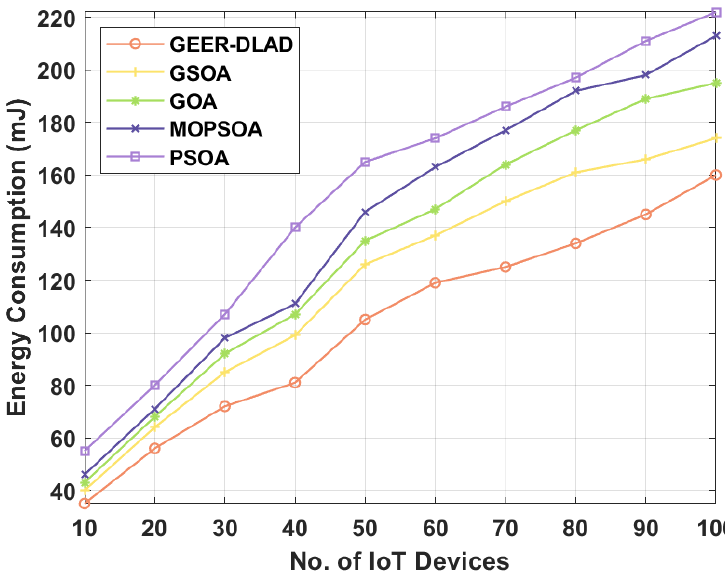
Figure 5. The Energy consumption analysis of GEER-DLAD model. Table 2. The Result Analysis of Existing with Proposed GEER-DLAD Method in terms of Network Lifetime